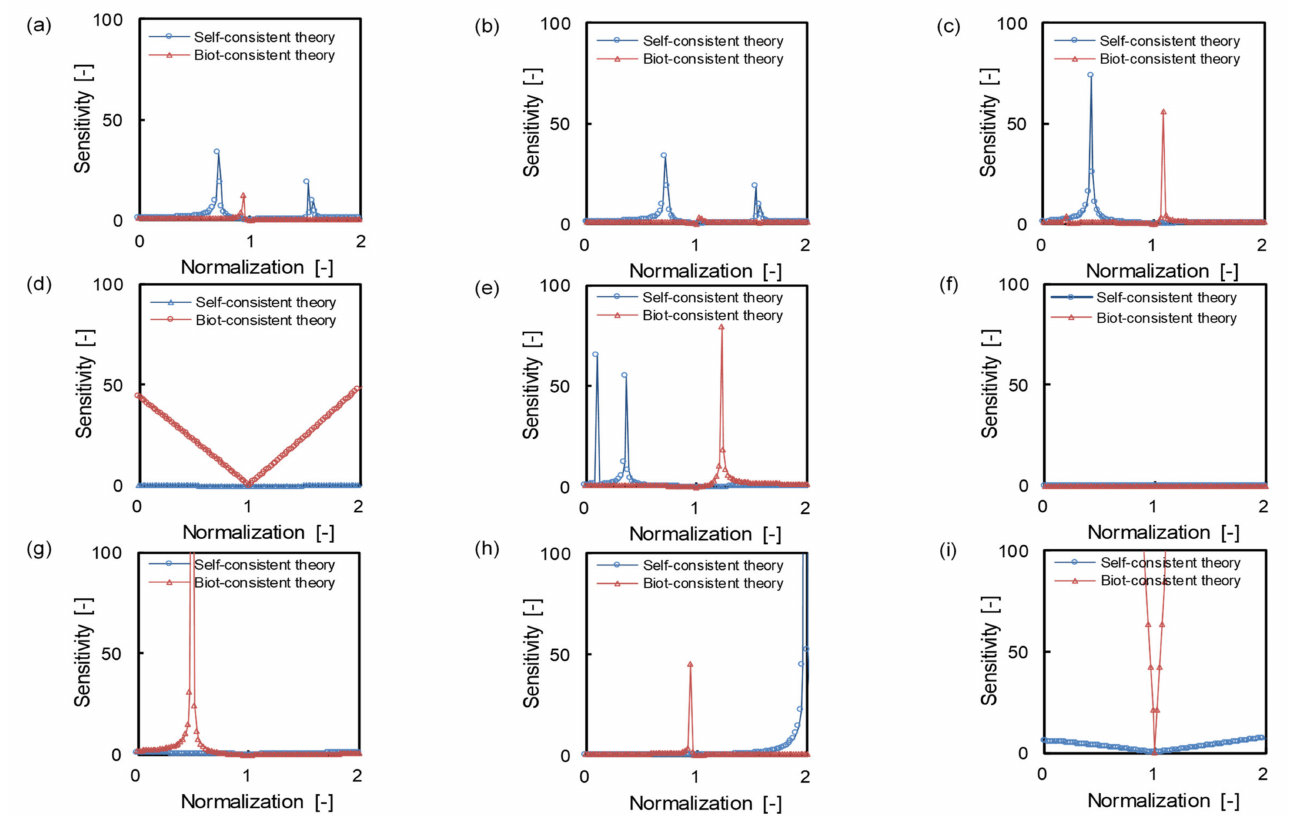
Figure 3. Results of sensitivity testing for ( a ) compressional wave velocity, ( b ) shear wave velocity, ( c ) mass density, ( d ) Poisson’s ratio, ( e ) bulk modulus of a grain, ( f ) bulk modulus of a skeleton, ( g ) bulk modulus of a fluid, ( h ) shear modulus, and ( i ) aspect